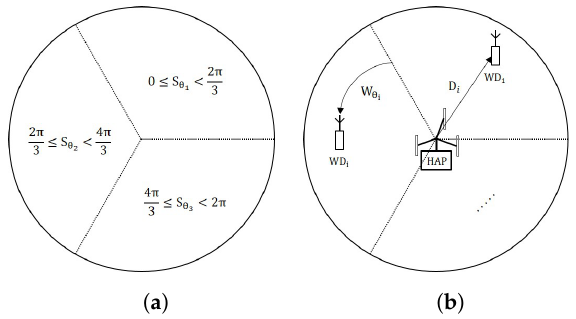
Figure 2. ( a ) Sector division. ( b ) Distance and angle of WD from